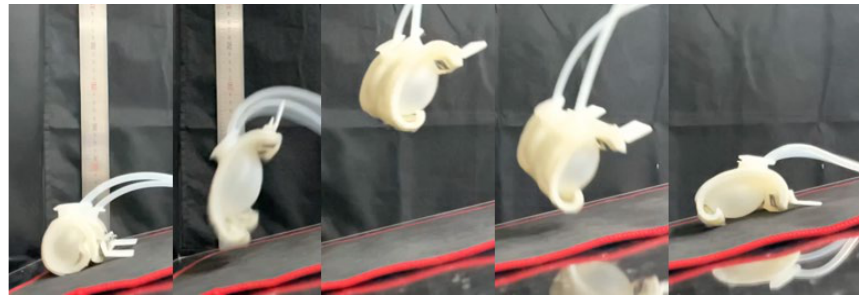
Figure 23. Jumping motion of soft jumping robots on 10° slope.